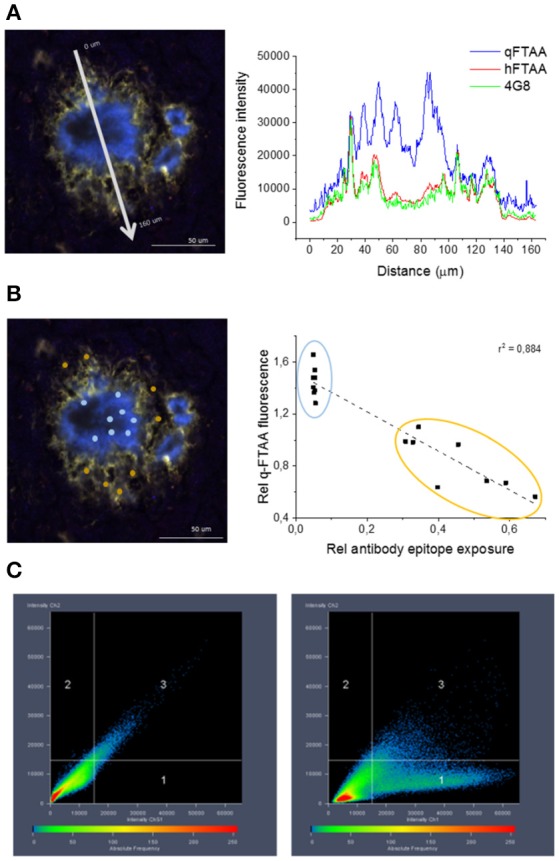
Co-localization of 4G8 antibody, q-FTAA, and h-FTAA in histological sample of APP23 mouse. (A) Intensities at different wavelengths over a cross section of one representative amyloid plaque in a 18 month old APP23 transgenic mouse brain. (B) Inverse correlation between signal from monoclonal 4G8-Aβ antibody and contribution of q-FTAA fluorescence (500 nm)/h-FTAA fluorescence (540 nm). ROIs selected for ratiometric analysis are indicated by colored dots and the corresponding data points are encircled with the same color in the graph. (C) High co-localization was displayed for h-FTAA and 4G8 antibody (left panel) and low for q-FTAA and 4G8 antibody (right panel).